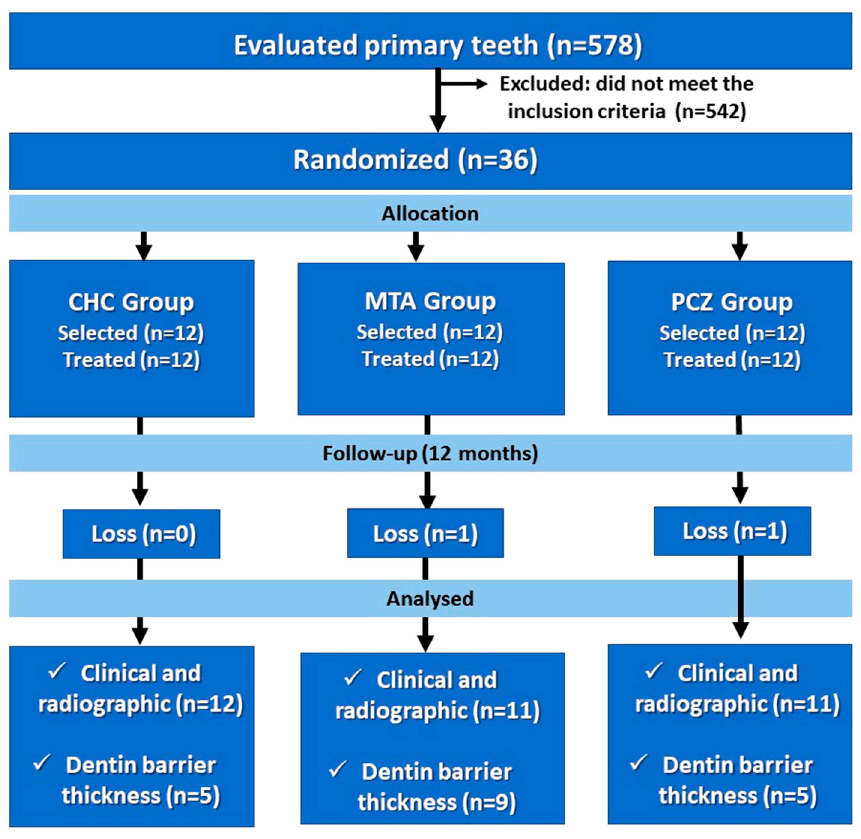
Figure 1- CONSORT study